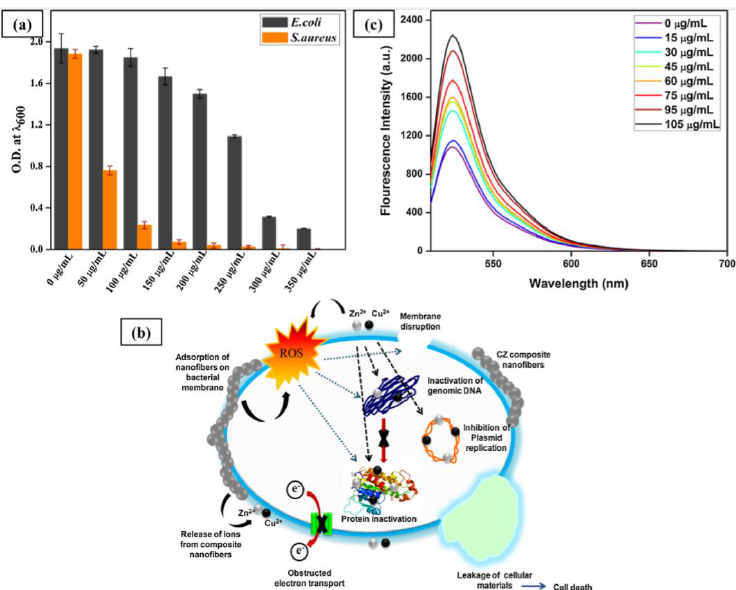
Figure 5. ( a ) Comparative plot representing the antibacterial activity of CuO-ZnO (CZ) loaded nanofibers with different concentrations against GFP- E. coli (G−) and S. aureus (G+); ( b ) Proposed mechanism of bactericidal action CZ nanofibers; and ( c ) Fluorescence spectra depicting the ROS generation with different concentrations of CZ nanofibers. Reprinted from [102], Copyright 2017, with permission from Elsevier.